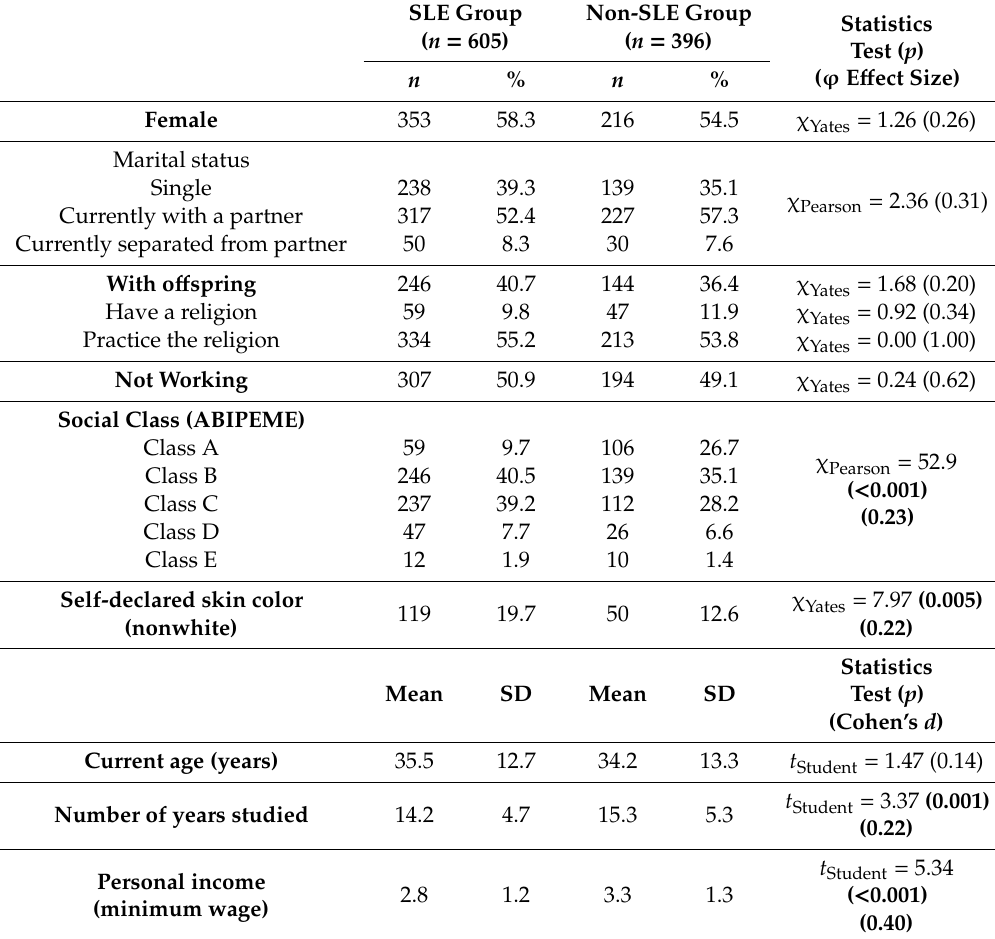
Table 1. Sociodemographic comparison between groups who have or have not experienced a stressful life event